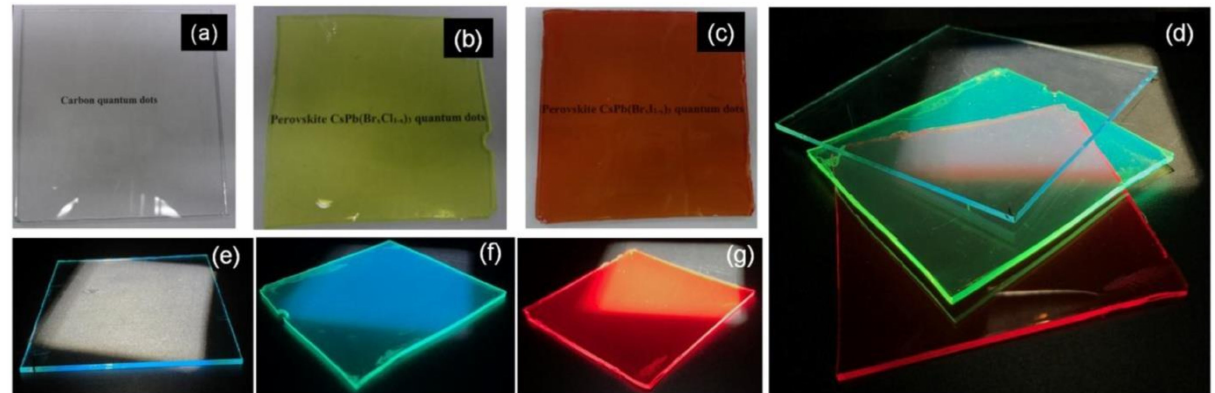
Figure 13. Photographs of the prepared LSC under ambient illumination ( a – c ) and one Sun illumination, 100 mW/cm 2 ( d – g ). Reprinted from ref. [172], with permission from